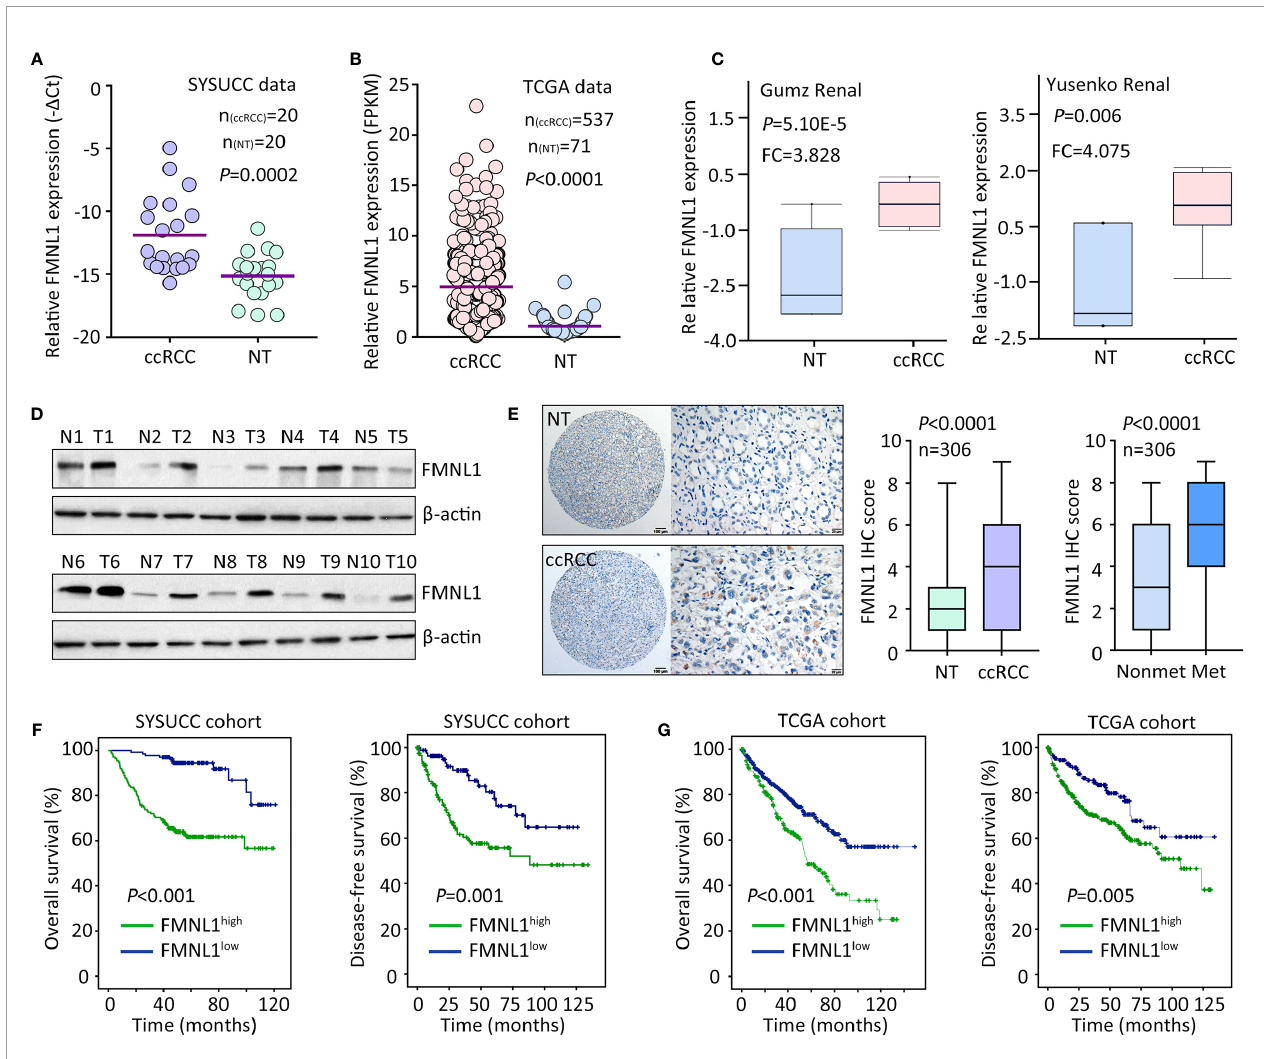
FIGURE 1 | FMNL1 is overexpressed in ccRCC. (A) Total RNA was extracted from 20 paired ccRCC and corresponding nontumorous tissues (NT) to examine the expression of FMNL1 mRNA by qRT-PCR. (B) The mRNA level in ccRCC patients from TCGA dataset was shown (C) . The upregulation of FMNL1 mRNA expression in ccRCC tissues was validated in previous studies of Gumz and Yusenko. (D) The protein expression of FMNL1 was examined by western blot in 20 ccRCC specimens. Representative images were shown. (E) A cohort containing 306 ccRCC patents was recruited to construct TMA. IHC was performed to indicate the FMNL1 expression. FMNL1 expression in tumor and nontumorous tissues, and in ccRCC tissues with or without tumor metastasis was indicated by box and whiskers. (F) Patients were divided into FMNL1 high and FMNL1 low groups, according to the IHC score of FMNL1 in ccRCC tissues. Kaplan-Meier survival analyses were performed to reveal the prognostic value of FMNL1 in overall and disease-free survivals of ccRCC patients. (G) The prognostic value of FMNL1 in ccRCC was con fi rmed in TCGA